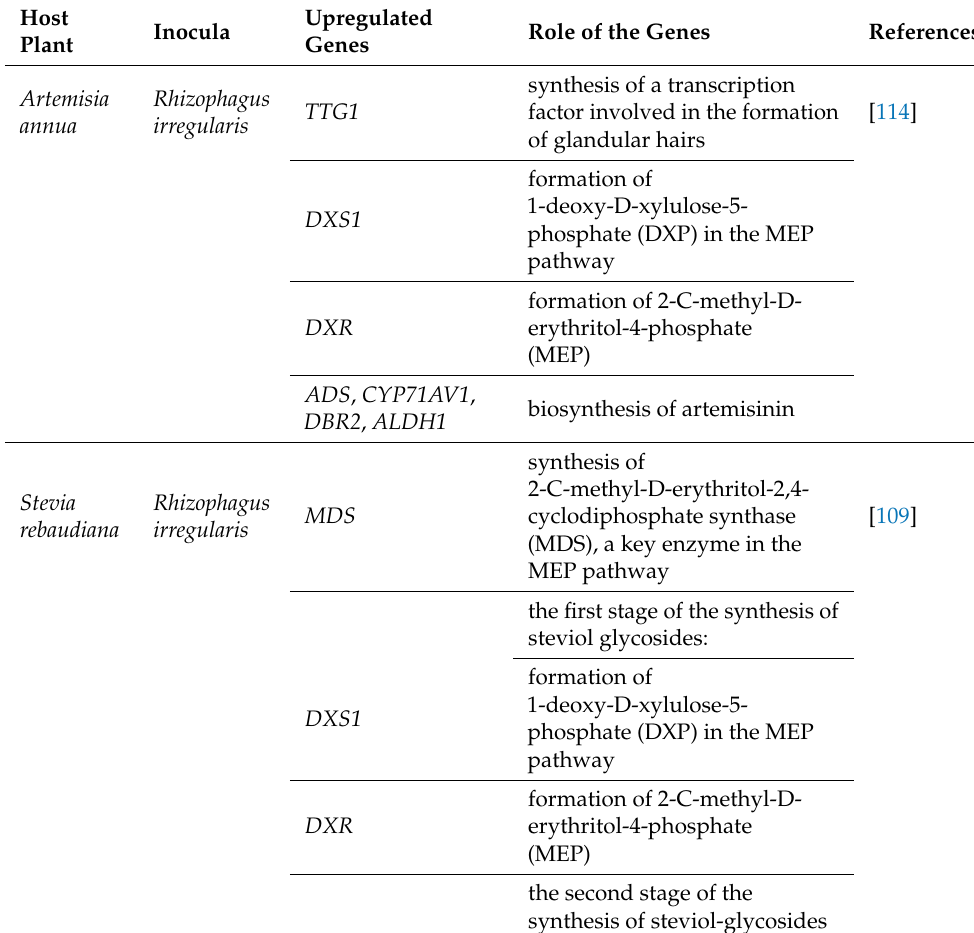
Table 2. Studies reporting mutualistic, symbiotic or parasitic microorganisms that affect gene tran- scriptions in